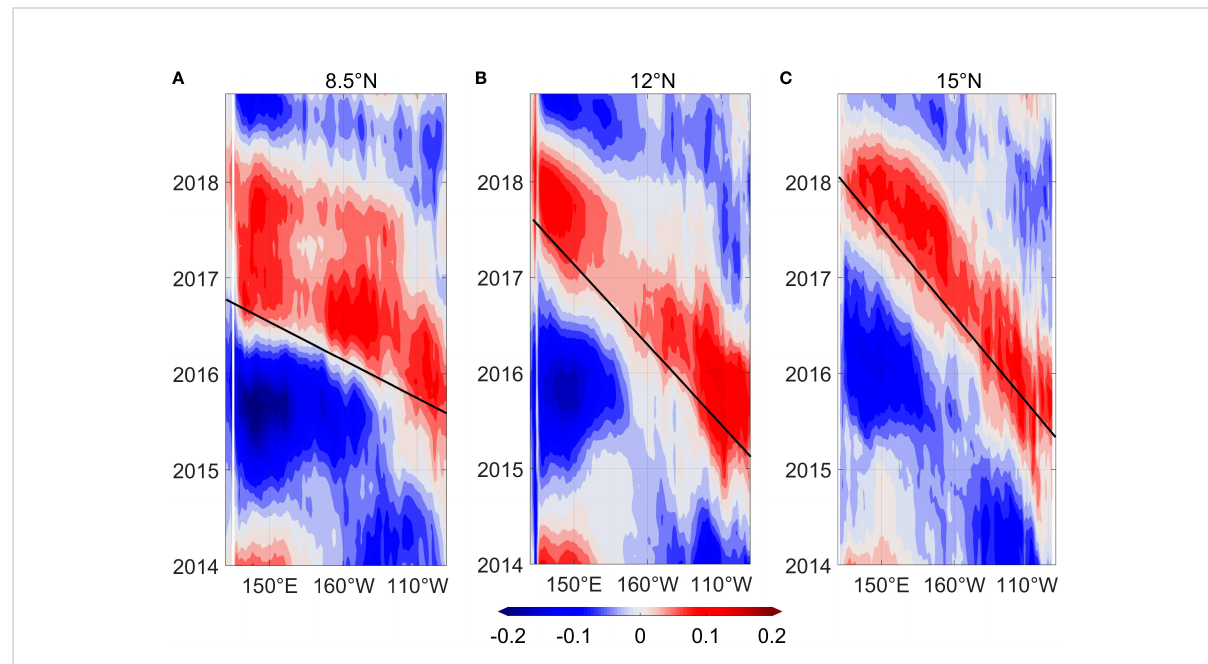
FIGURE 7 Hovmöller diagrams of the SSHA (m) along (A) 8.5°N, (B) 12°N, and (C) 15°N from AVISO products during January 2014 and December